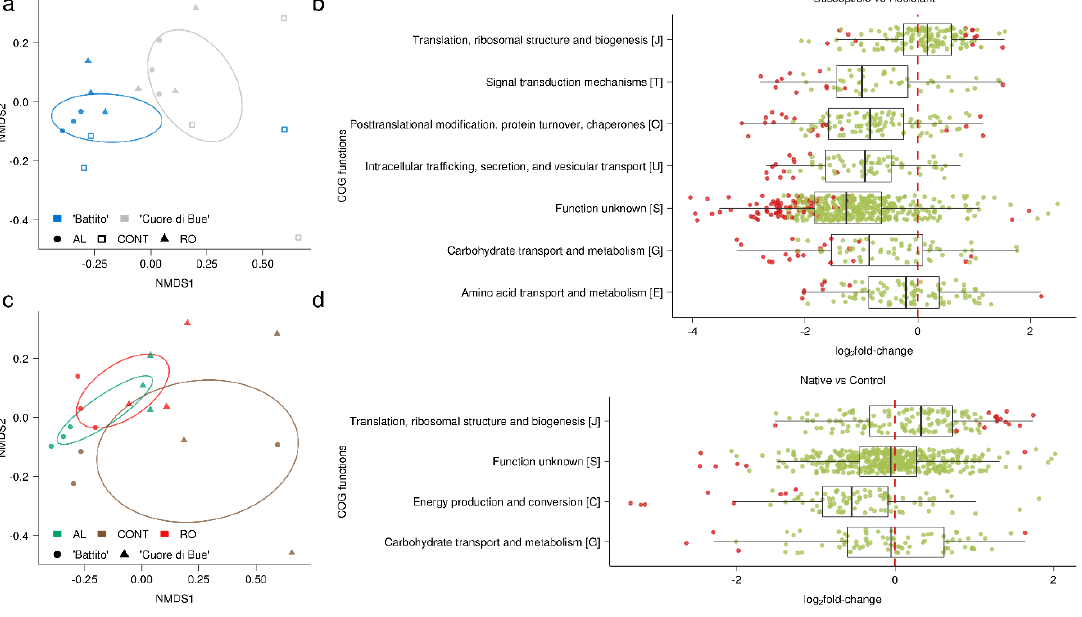
Figure 4. Meta-transcriptome functional diversity. ( a , c ) non-metric multidimensional scaling (NMDS) ordination plots on Bray–Curtis distances of expressed Clusters of Orthologous Groups (COG) functions clustered using 95% confidence ellipses by genotype ( a ) and substrate type ( c ); stress = 0.0776. AL, “Albenga” suppressive soil; RO, “Rosta” conducive soil; CONT, neutral control soil. ( b , d ) Boxplot of di ff erentially expressed COG functions (FDR < 0.05) between genotypes (susceptible versus resistant, ( b ), and substrate type (native versus control soils, ( d )). COGs are clustered by the more frequently represented functional categories, and points represent COG terms for each functional category; COGs that are significantly di ff erentially expressed (FDR < 0.05) are indicated in red, COGs that are not in light green.